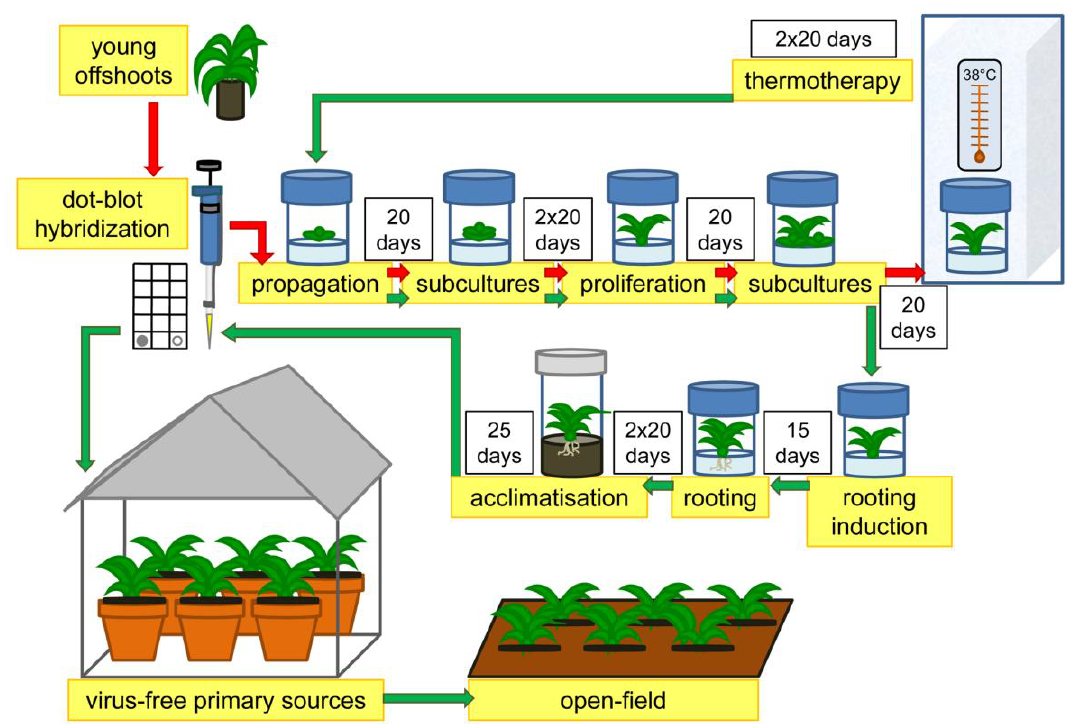
Figure 2. Schematic representation of sanitation workflow to produce virus-free artichoke plants using in vitro meristem-tip culture combined with thermotherapy. Red arrows indicate the workflow of sanitation protocol performed on young offshoots collected from farmers until thermotherapeutic treatment. Green arrows indicate the workflow of sanitation protocol performed after thermotherapy treatment.